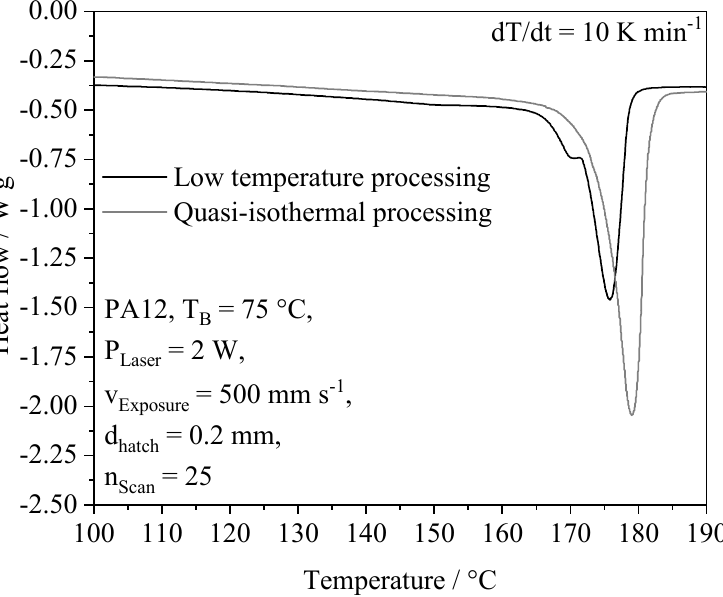
Figure 13. Differential scanning calorimetry of specimens manufactured using non-isothermal PBF and isothermal PBF.